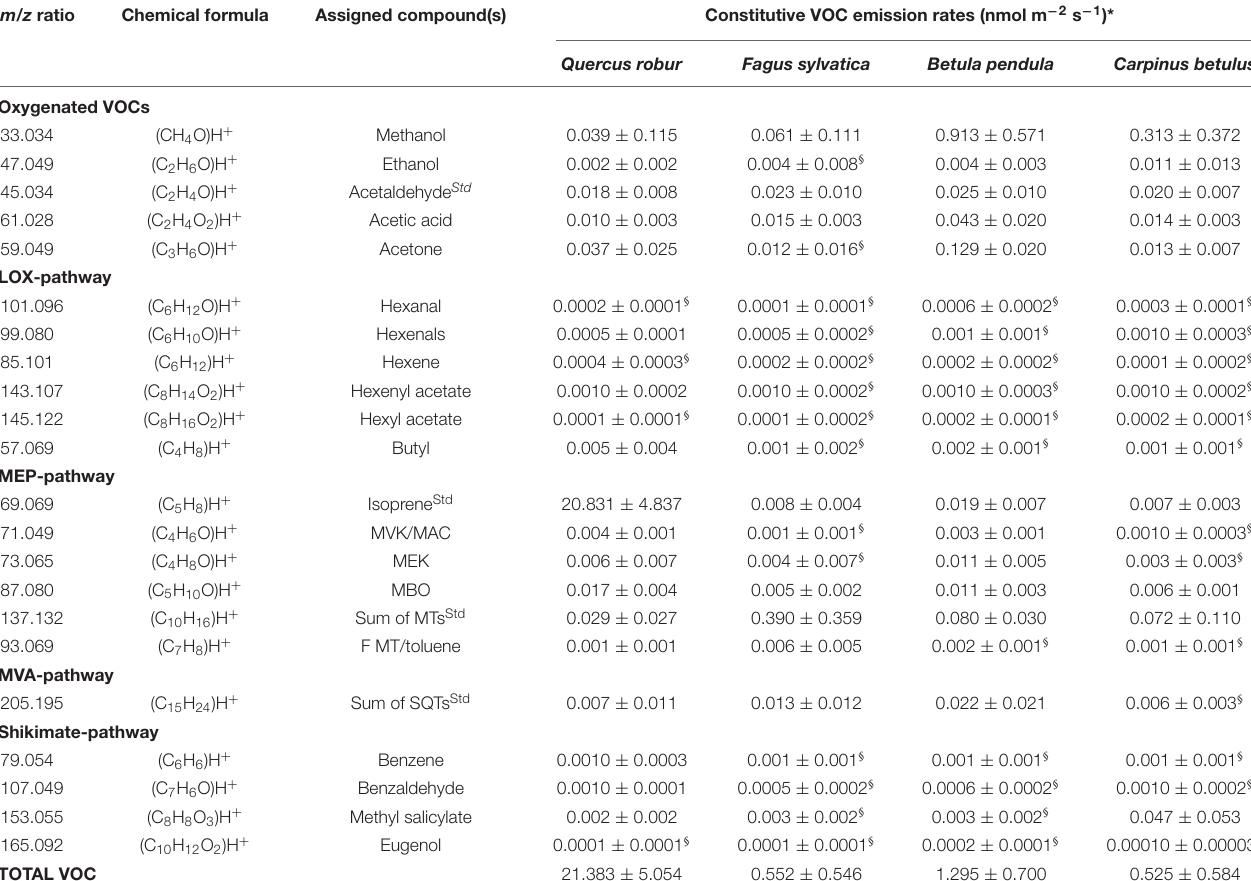
TABLE 1 | Constitutive VOC emission rates (nmol m − 2 s − 1 ) of Q. robur, F. sylvatica, B. pendula , and C. betulus seedlings (Mean ± SD). m/z